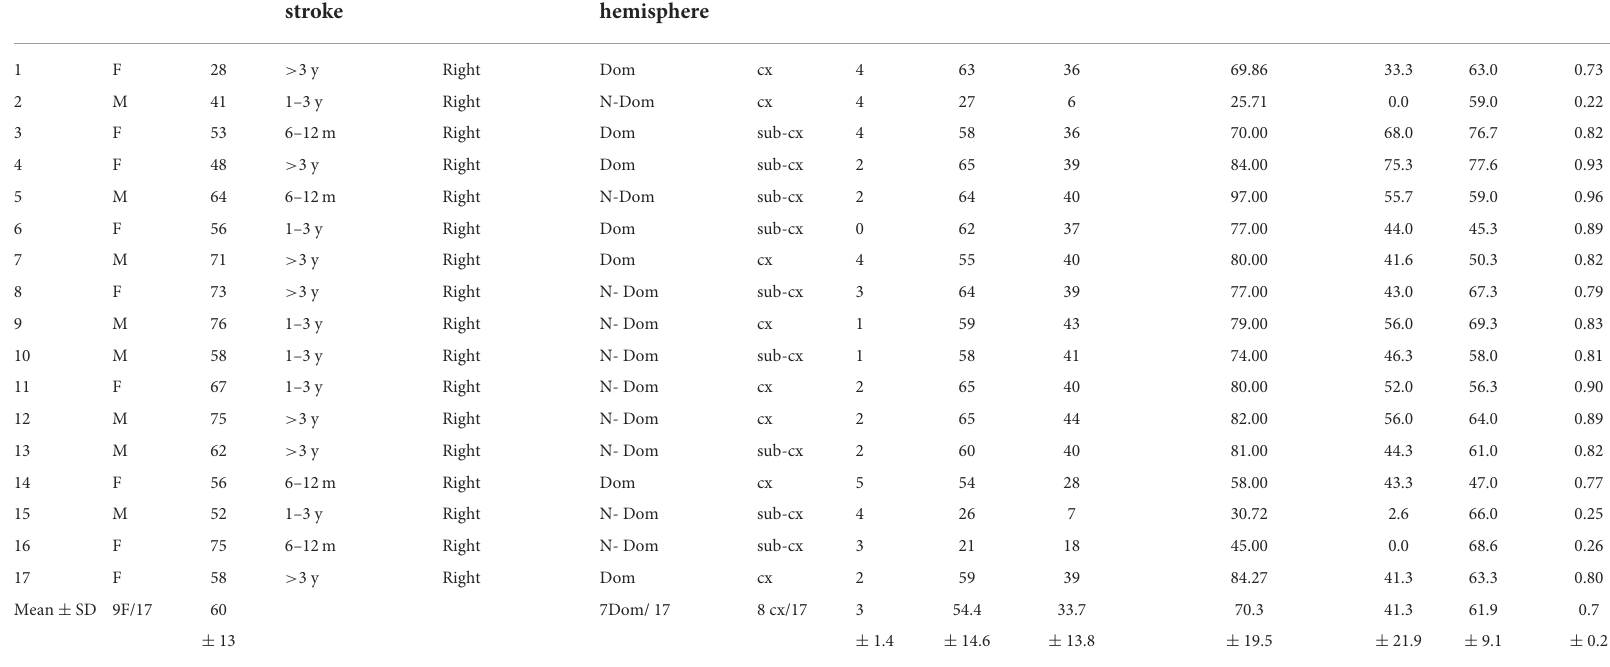
TABLE 1 Patients with stroke: Demographic data and baseline